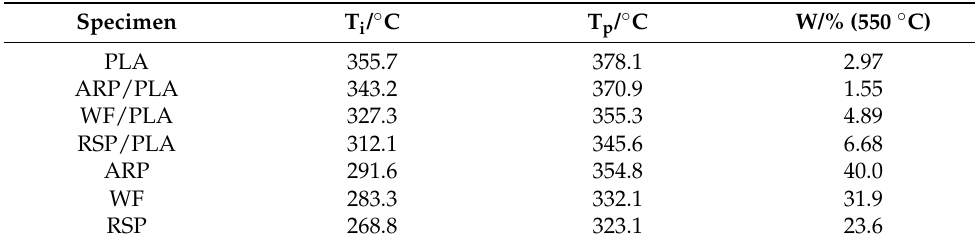
Figure 5. The mass loss curves of different samples. Table 1. Thermogravimetric analysis information of different samples.